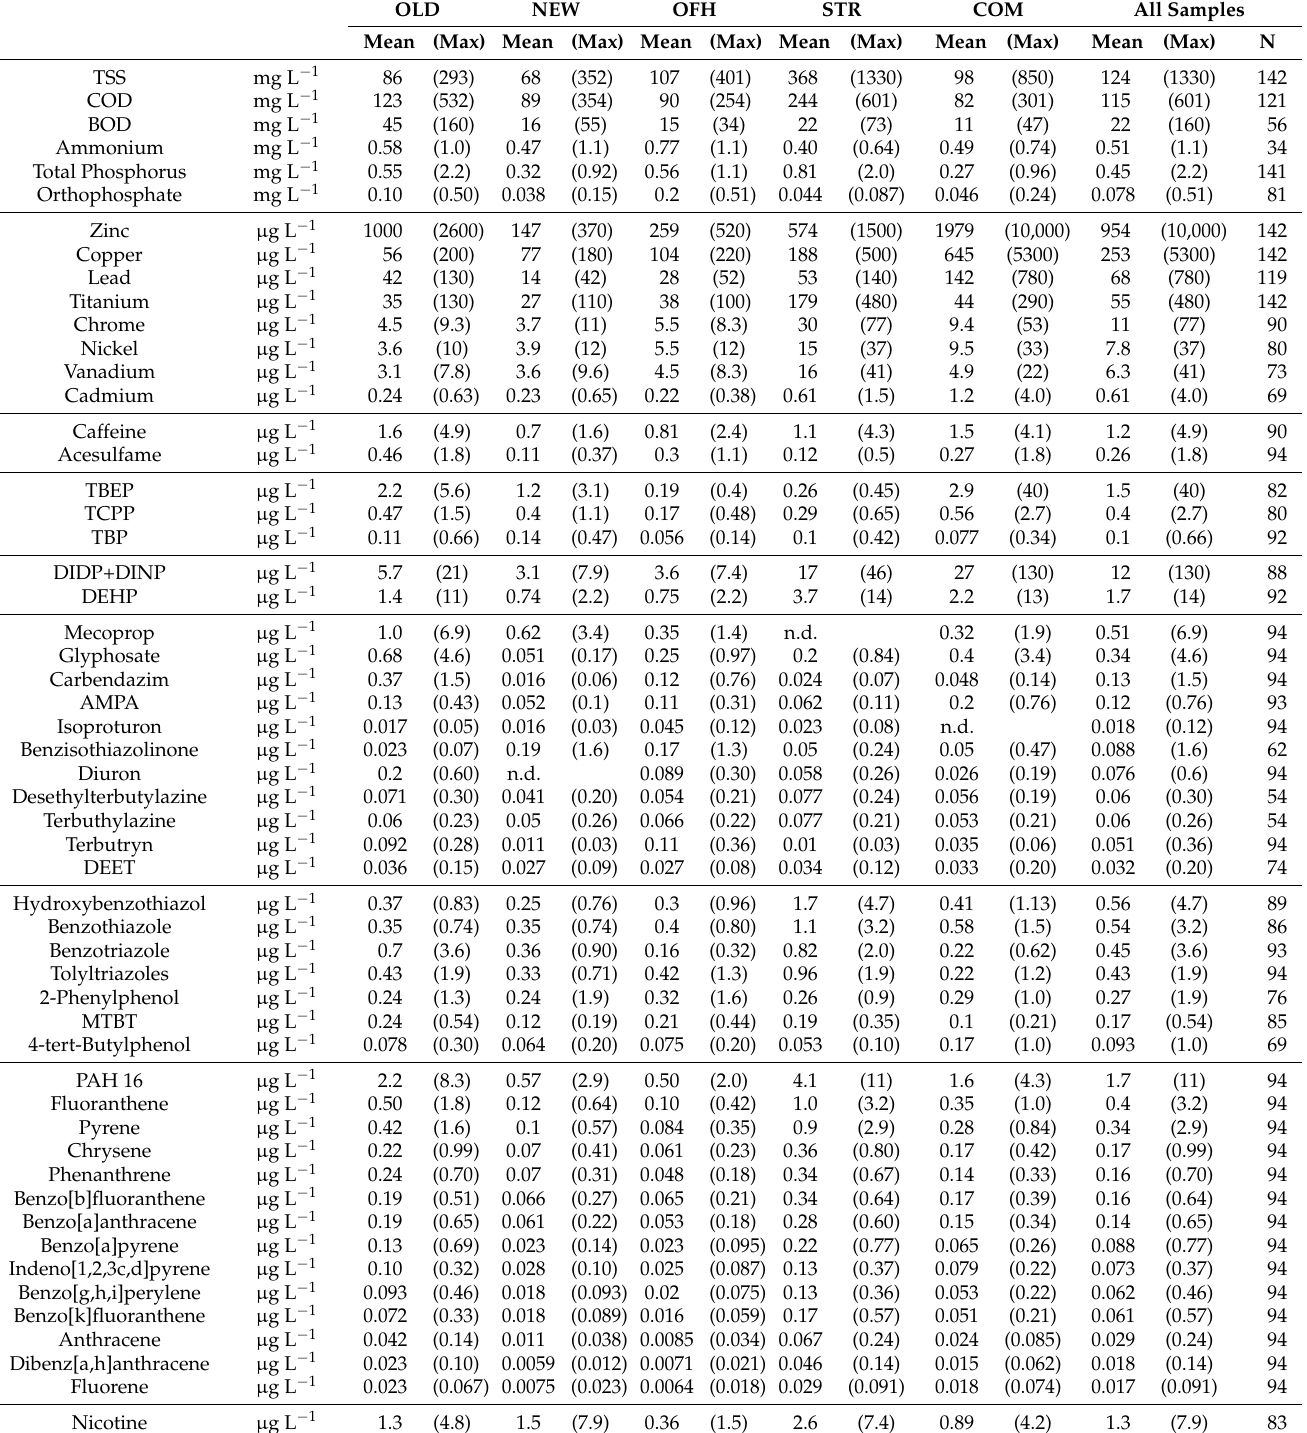
Table 4. Concentrations of standard parameters and micropollutants in stormwater runoff of different catchment types (only substances with >30% of all samples above LOQ). See Table 3 for